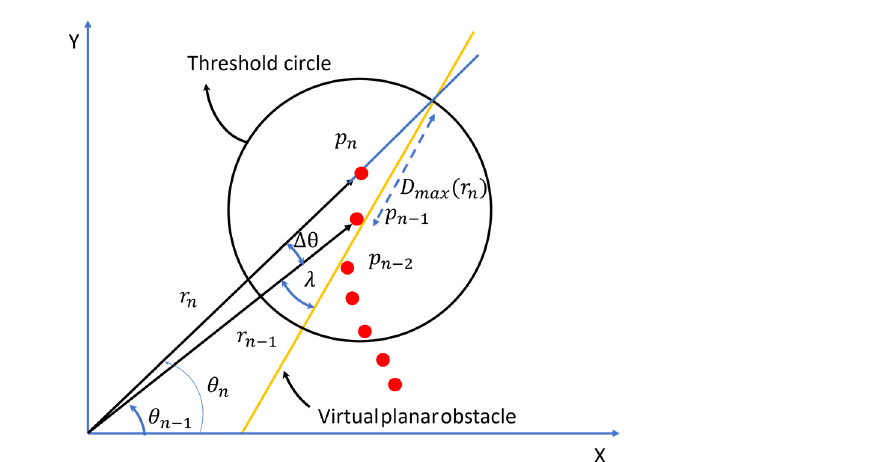
Figure 9. Adaptive break point detector.